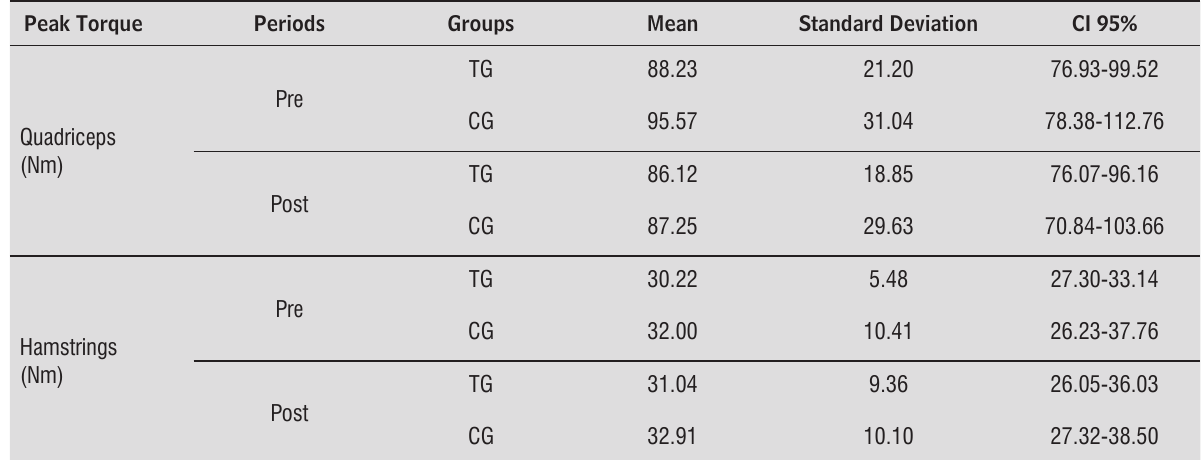
Table 1 - Descriptive statistics of quadriceps and hamstring peak torque in the groups Peak Torque Periods Groups